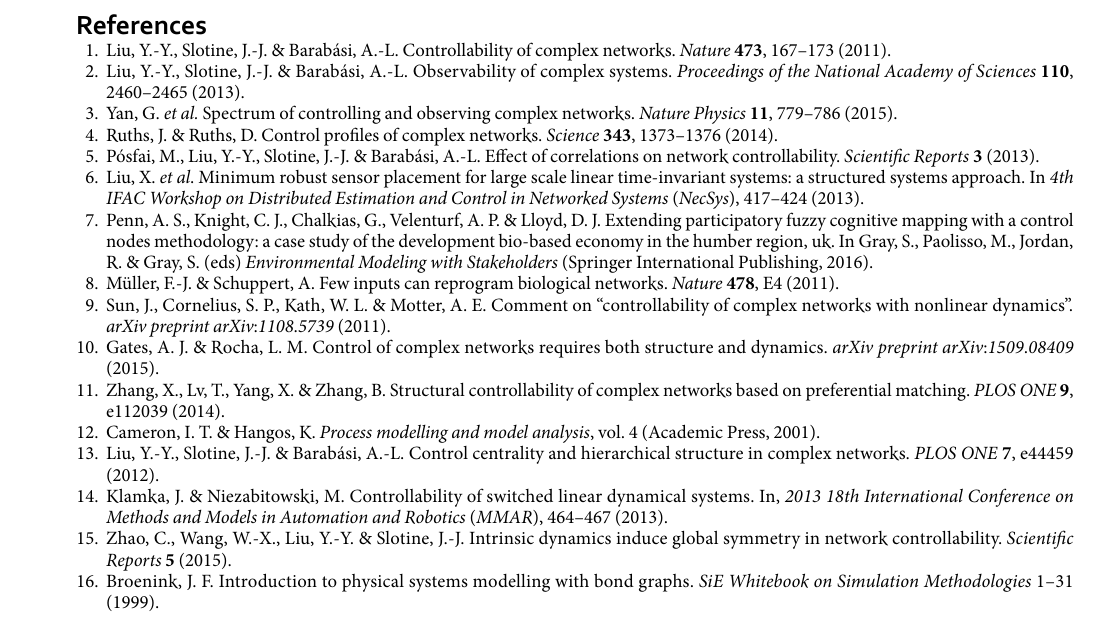
model. In the case of dynamical systems when the integrating behaviour and balance equation related relations among the state variables were also taken into account the number of necessary drivers and sensors decreased drastically compared to the analysis of oversimplified structural networks. For determining driver and sensor nodes a new approach was also recommended.